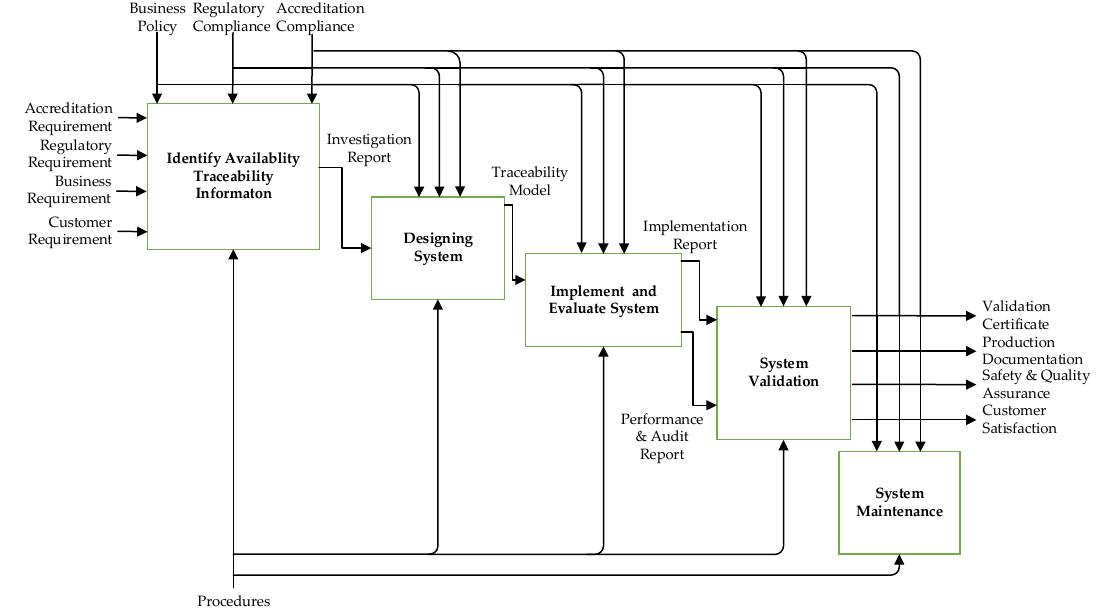
Figure 4. IDEF-0 implementation in internal Figure 4. IDEF‐0 implementation in internal traceability.